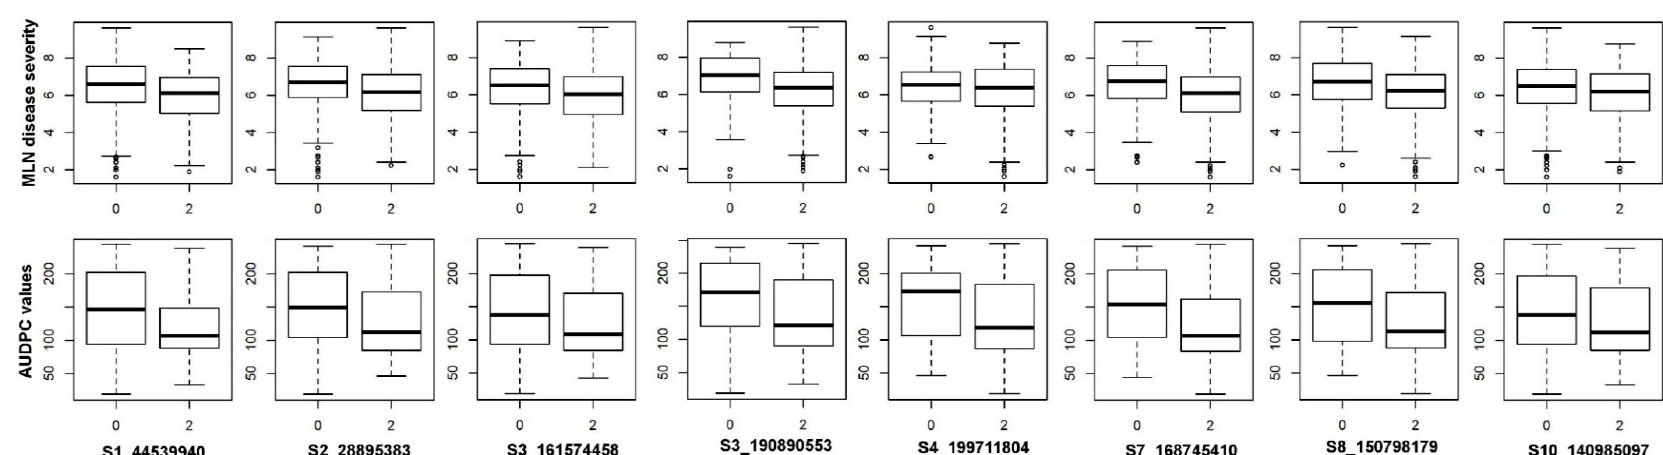
Figure 5. Box plots showing the phenotypic values of the different allele classes of eight SNPs identified in GWAS for MLN disease severity and AUDPC value. The SNP names and alleles are mentioned below. The black horizontal lines in the middle of the boxes are the median values for the MLN disease severity and AUDPC value in the respective allele classes.